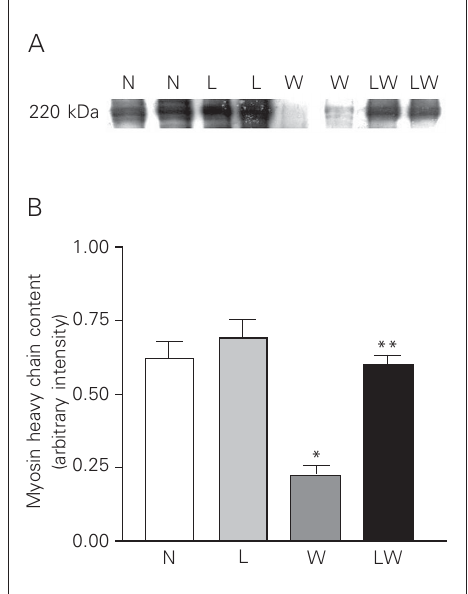
Figure 1. A , Analysis of myosin heavy chain content in gastroc- nemius muscle of control (N), Walker 256 carcinosarcoma- bearing rats (W), control rats fed a leucine-supplemented diet (L), and tumor-bearing rats receiving a leucine-supplemented diet (LW). The blot is representative of 8 muscle samples from each group. Homogenized fractions from whole gastrocnemius muscle protein (5 µg) were probed with a monoclonal anti- body against myosin heavy chain as described in Methods. B , Den- sitometric analysis of myosin heavy chain content in gastroc- nemius muscle from four sepa- rate blots (means ± SEM for 8 animals in each group). *P < 0.001 for the N group compared to the W group; **P < 0.001 for the W group compared to the LW group (two-way